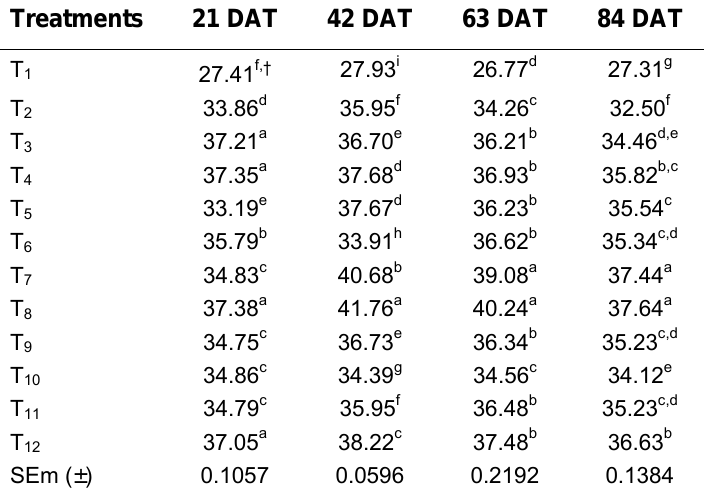
Effect of Different Treatments of N on SPAD Readings in Rice (Pooled Mean of 2001–2002 and 2002–2003)